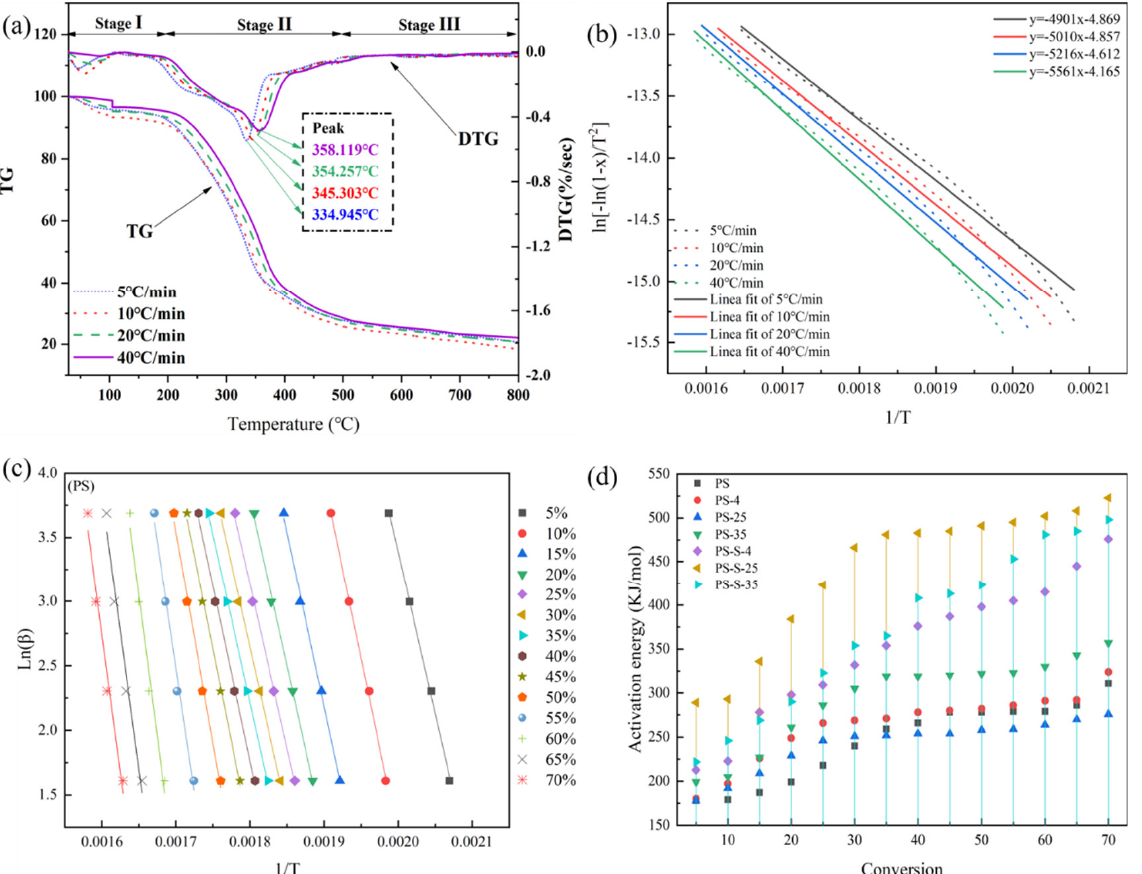
Figure 4. ( a ) TG and DTG curves of PS sample, ( b ) Coats-Redfern model of PS sample, ( c ) Flynn- Wall-Ozawa (FWO) model of PS sample, ( d ) activation energy of PS sample.